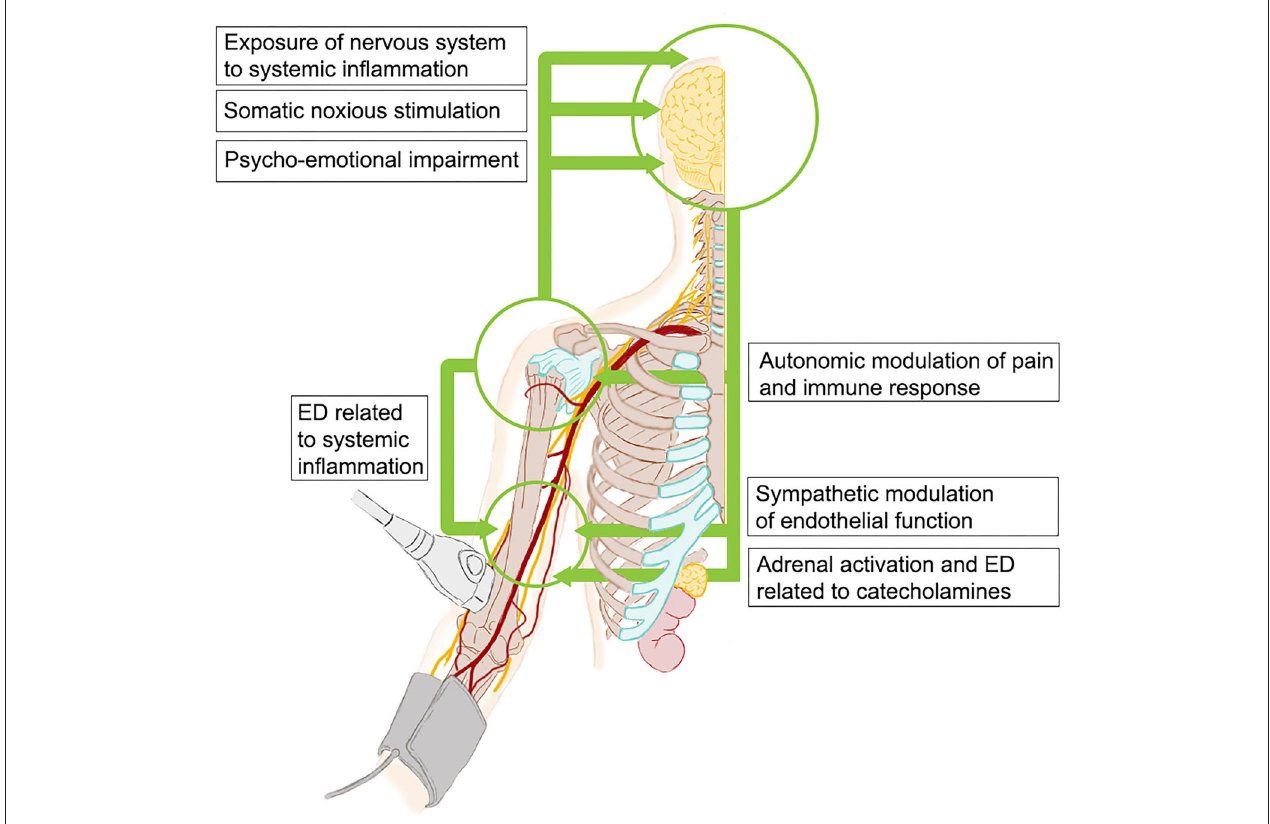
FIGURE 3 | Potential mechanisms of interconnections between neurohormonal system, inflammation, and endothelium in patients with PsA and depressive symptoms. PsA, psoriatic arthritis; ED, endothelial